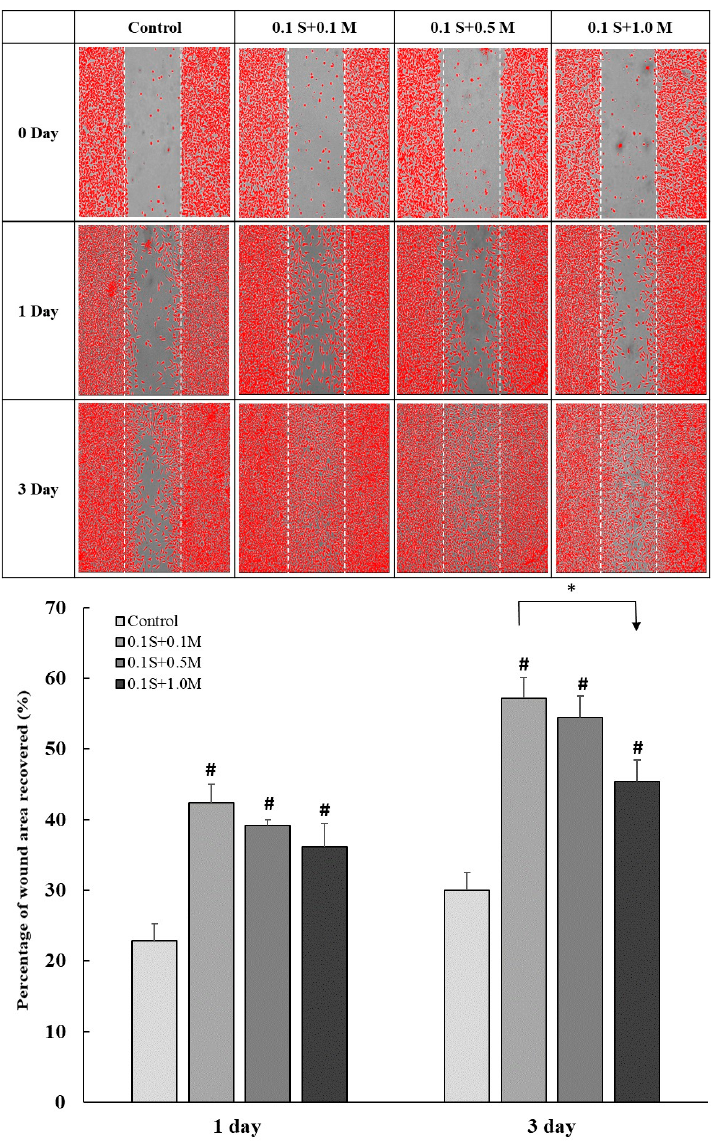
Figure 7. Wound healing rate of the sericin and MSM blends according to an in vitro scratch assay using L929 fibroblast (Upper: Image. Lower: Quantitative Analysis). Cells were treated with 1.0 (0.1S + 0.1M), 5.0 (0.1S + 0.5M), and 10.0 (0.1S + 1.0M) mg/mL MSM at 1.0 mg/mL sericin. All values are presented as the mean ± standard deviation (n = 3). # p < 0.05 vs. CON. * p < 0.05.